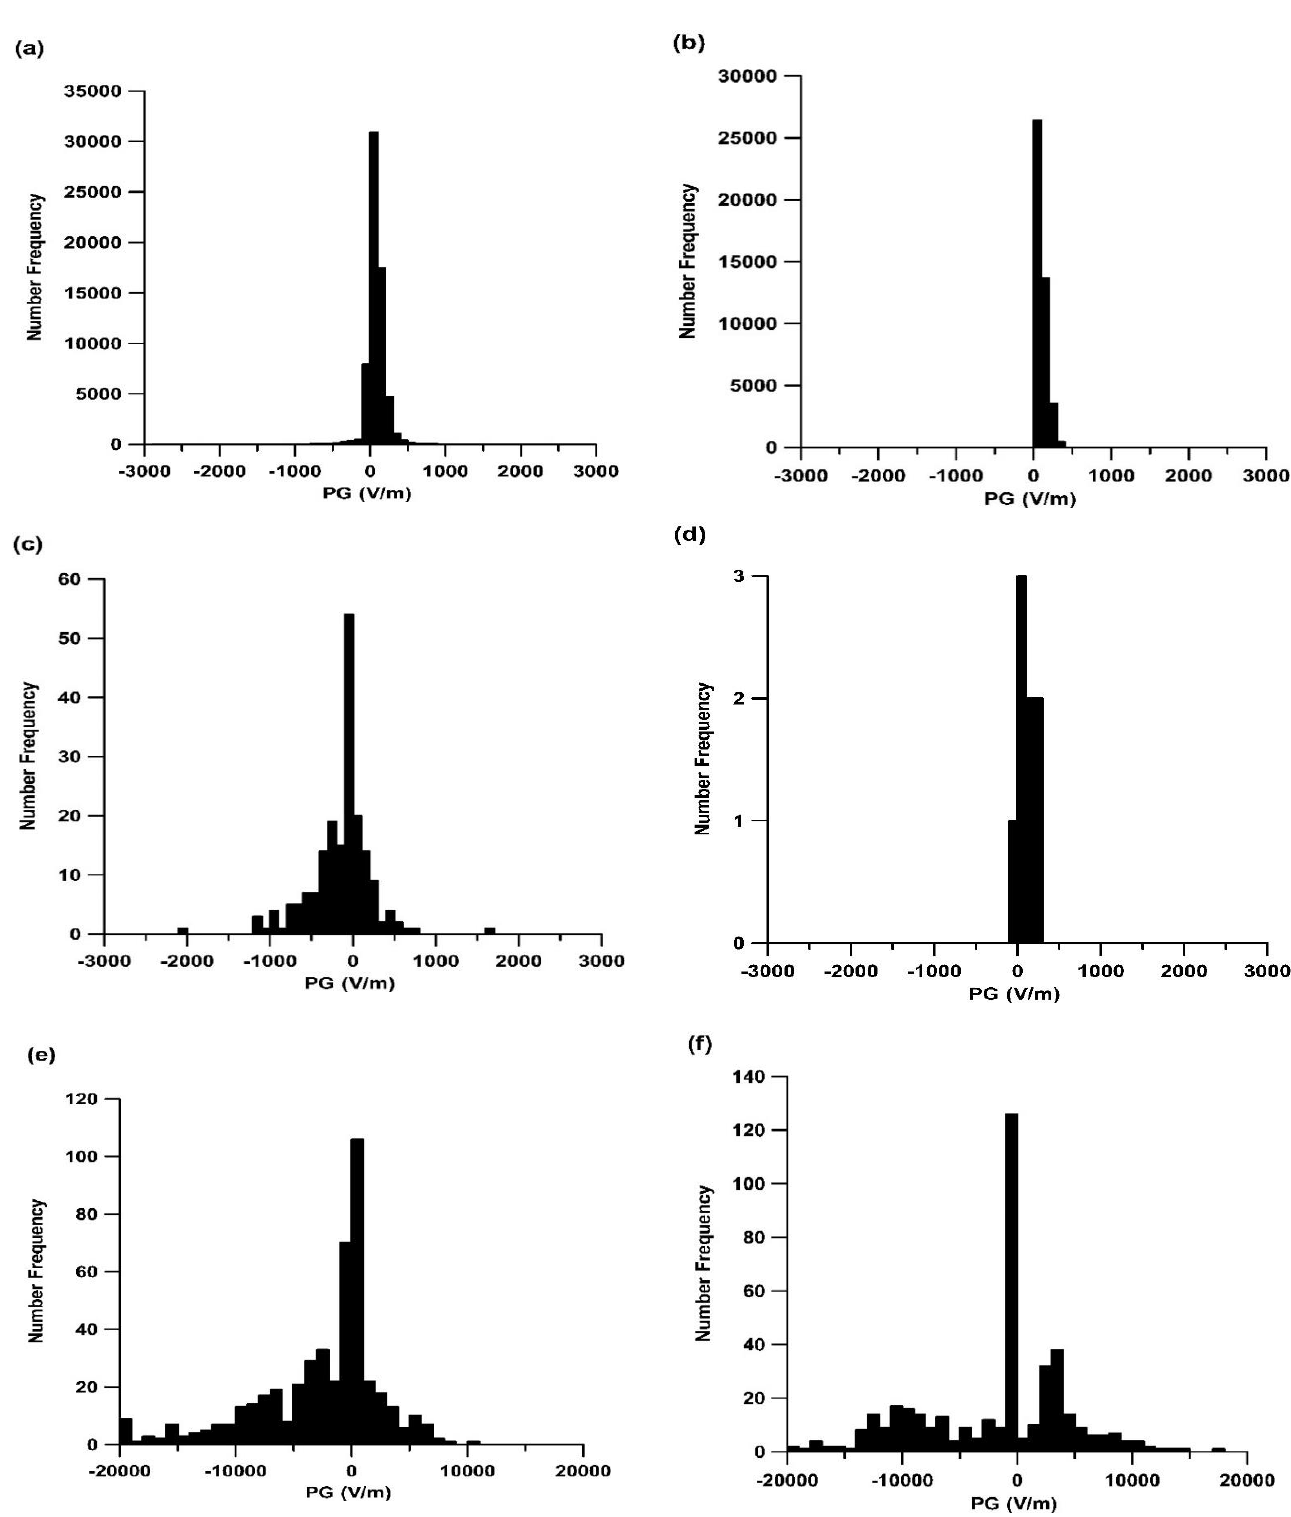
Figure 5. Frequency distribution of PG: ( a ) all data (hourly values, bins of 100 V/m), 0.6% of the values are outside the depicted axis; ( b ) fair weather (hourly values, bins of 100 V/m); ( c ) rain (hourly data, bins of 100 V/m); ( d ) at the hour after rain stopped (hourly data, bins of 100 V/m); ( e ) during the half hour after the start of hail (1-minute data, bins of 1000 V/m); ( f ) during the first hour of snowfall (1-minute data, bins of 1000 V/m). Note that ( a – d ) have different PG axis scales than ( e , f ).